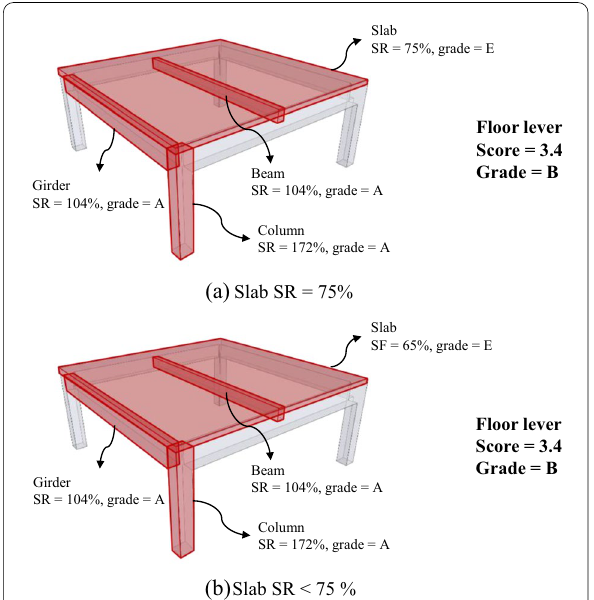
Fig. 2 Evaluation example for floor level using KISTEC